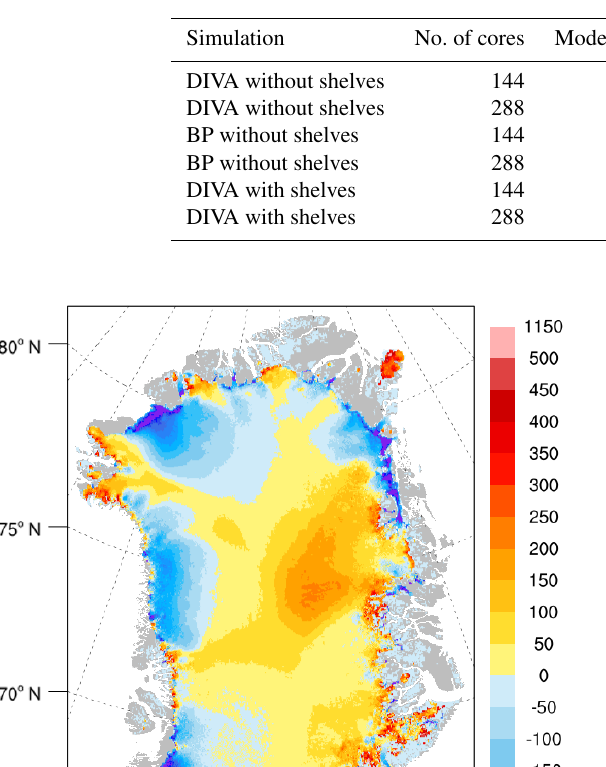
Table 3. Computational performance on NCAR’s Cheyenne supercomputer for various simulations: DIVA vs. BP solvers, with and without floating ice shelves, and 144 vs. 288 processor cores.